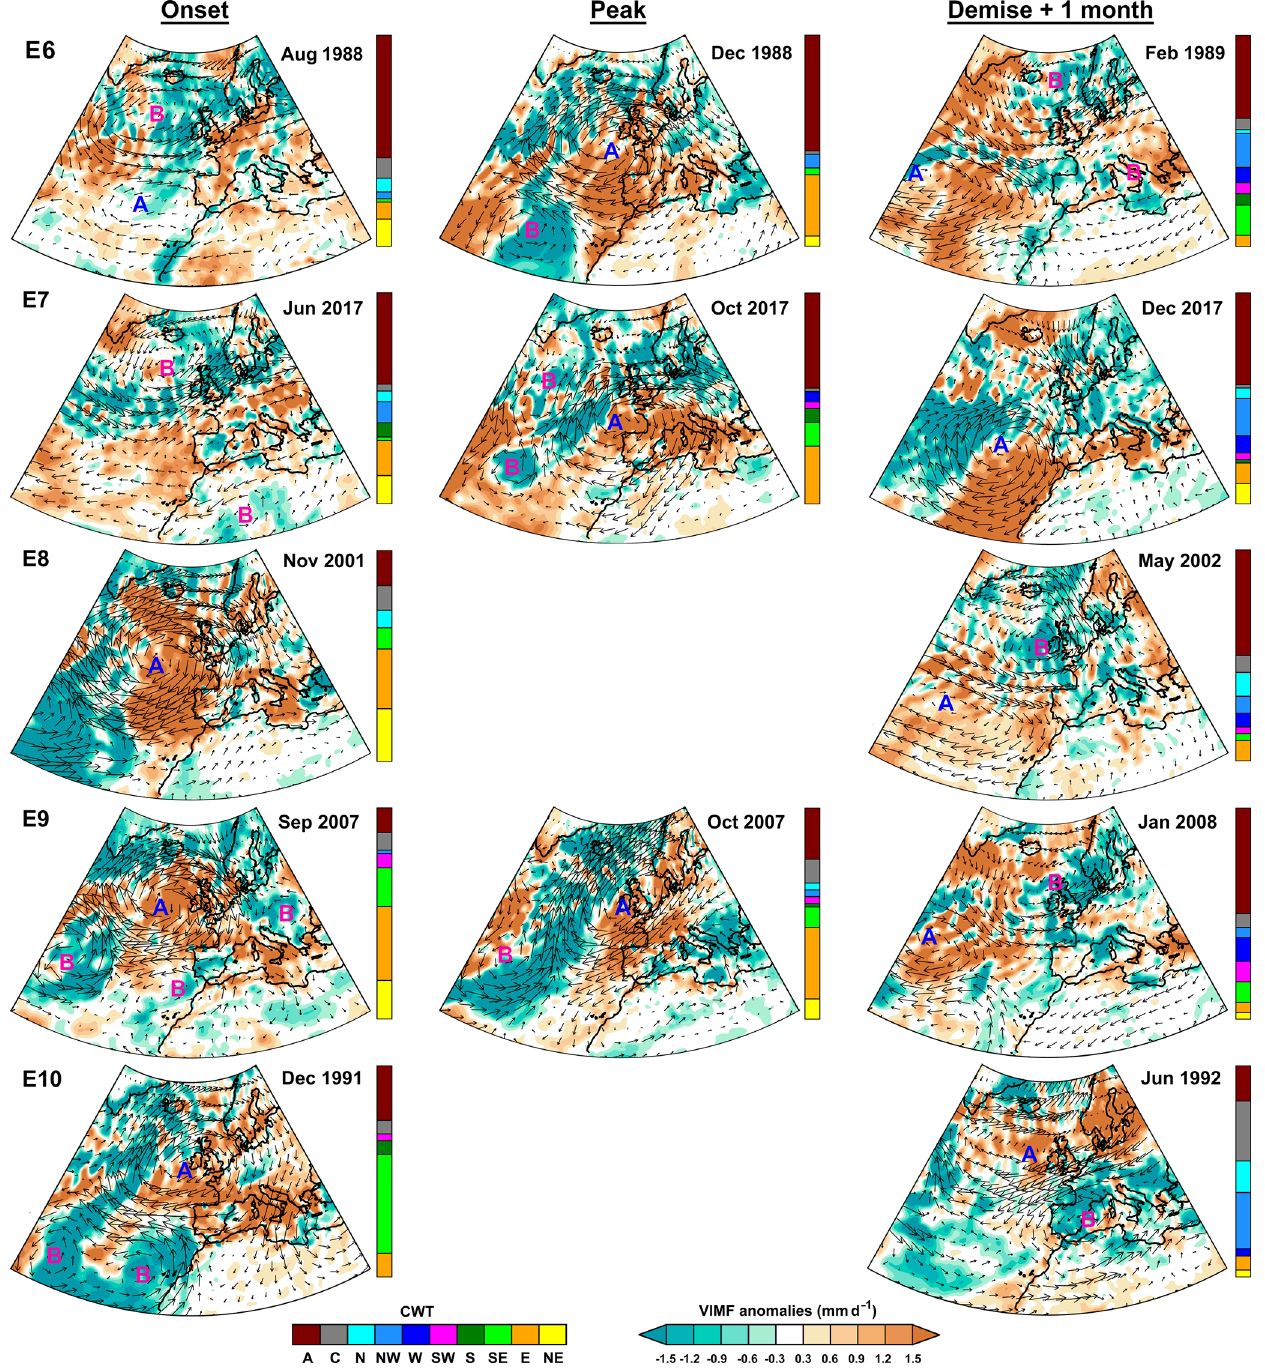
Figure 14. The monthly anomaly of the VIMF (in arrows) and its divergence (shaded) during 1980–2017 for the onset, peak, and 1 month after the termination of each of the 10 most severe drought episodes (Es) listed in Table 3. Anticyclonic (or cyclonic) centres of the VIMF anomalies circulations are represented as A (or B). Vertical bars show the monthly percentage of each pure circulation weather type